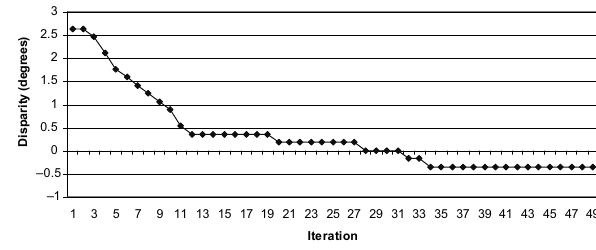
Figure 10 Evolution of the disparity error in one of the experiments.